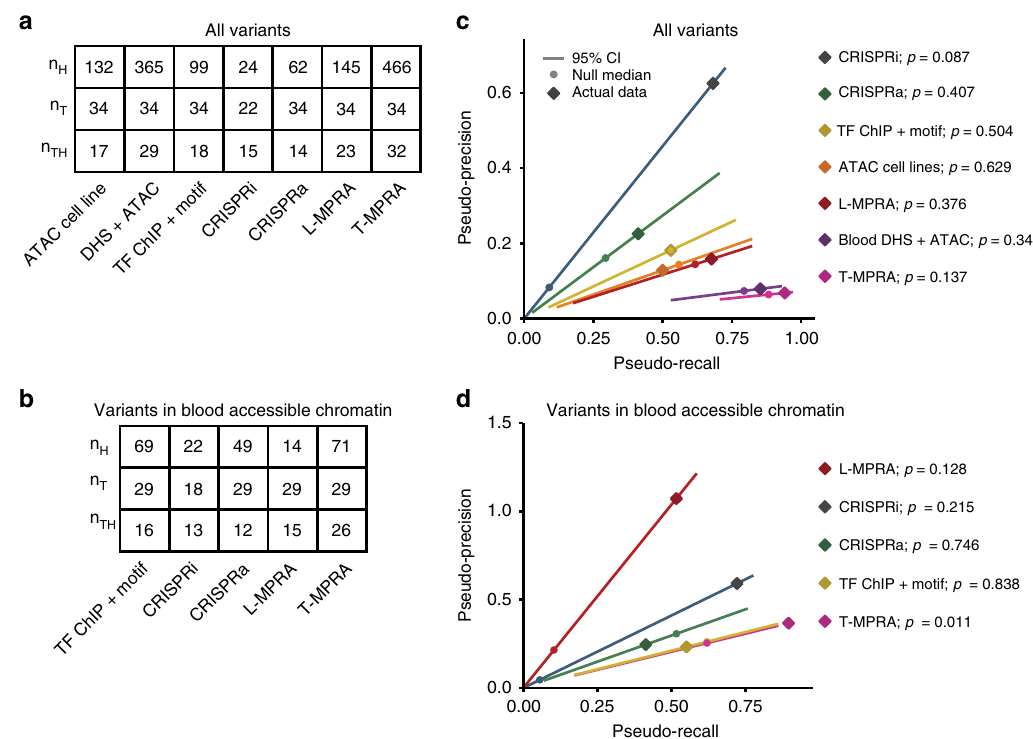
Fig. 3 Comparison of GWAS enrichment across methods. a , b Values for n H , n T , and n TH for all methods, considering ( a ) all variants, and ( b ) only variants in open chromatin. c , d Pseudo-precision ( y axes) and pseudo-recall ( x axes) for GWAS enrichment for each assay (colors), with diamonds depicting the actual assay performance (as in Supplementary Fig. 9a), and the lines depicting the 95% CI of each assay ’ s null distribution (as in Supplementary Fig. 9b). Empirical one-sided P -values derived from the genomic-shifts null are indicated next to each assay label. P -values are not corrected for multiple hypothesis testing. c Each assay evaluated individually for all tested variants and d considering only SNPs in blood cell accessible chromatin. The relationship between pseudo-precision and pseudo-recall is linear in the null (pseudo-precision = ( n T / n H ) × pseudo-recall) because both are proportional to n TH and n T and n H are